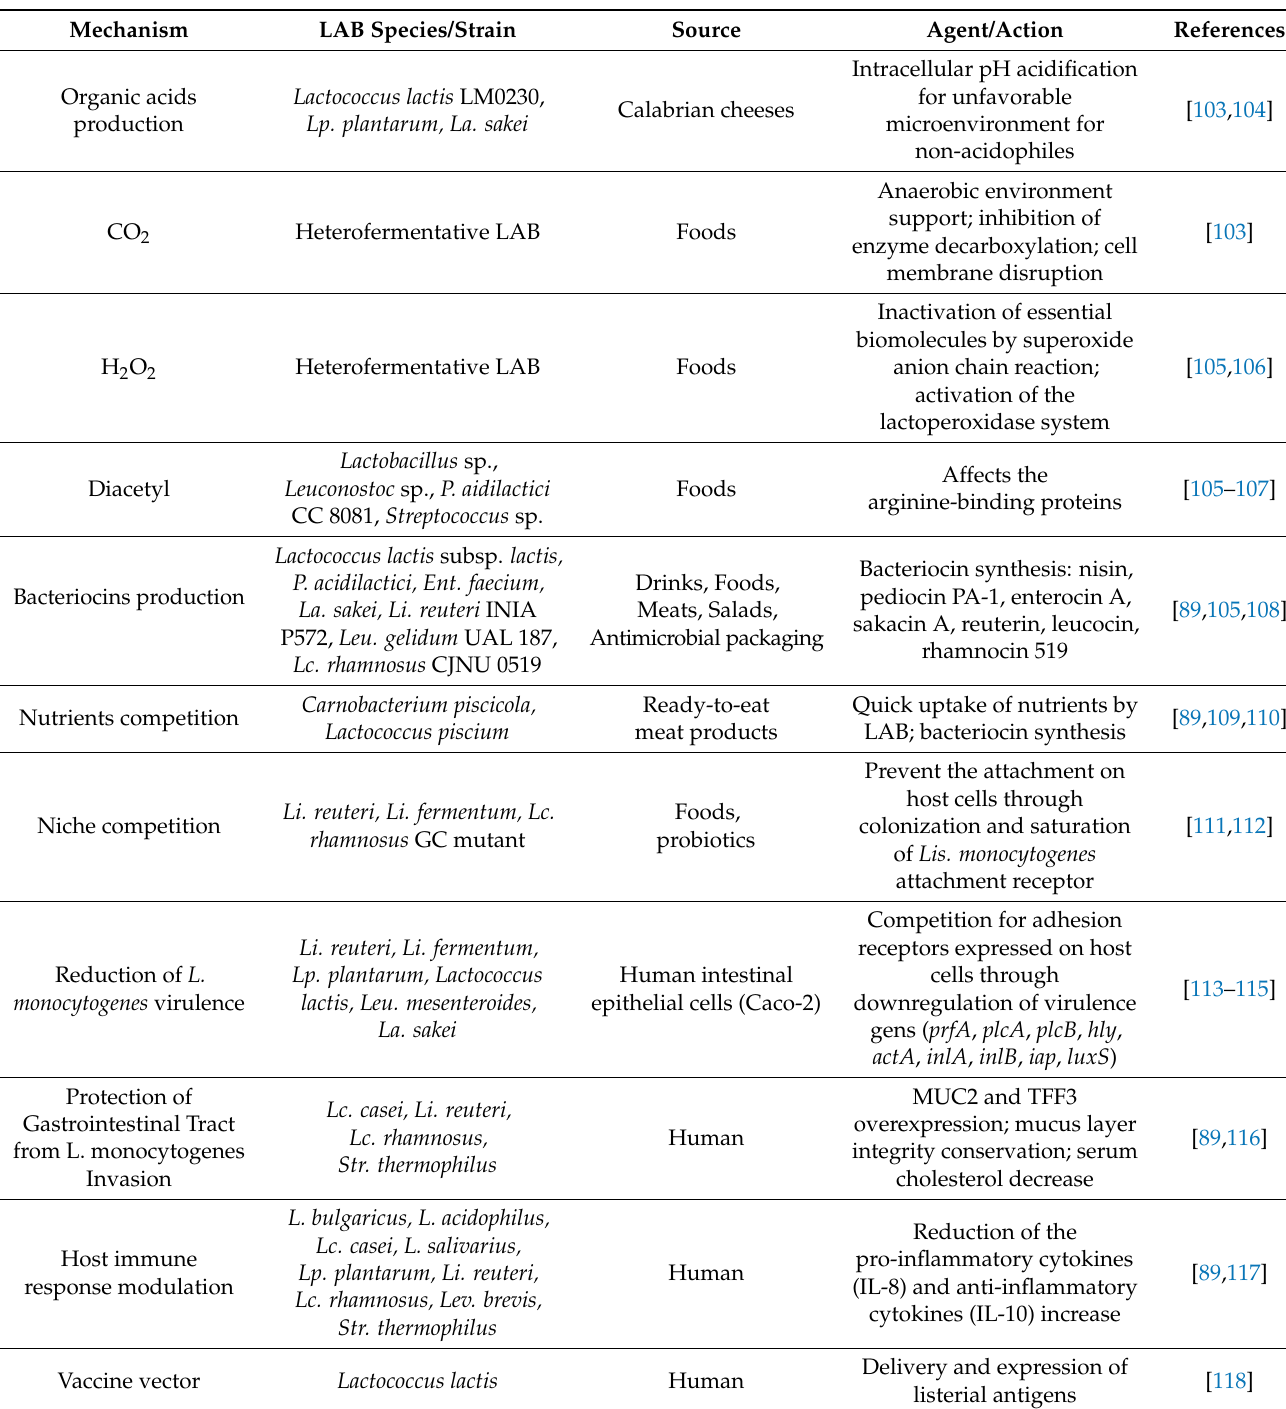
Table 2. Antibacterial activity of lactic acid bacteria (LAB) against Listeria monocytogenes toxigenic